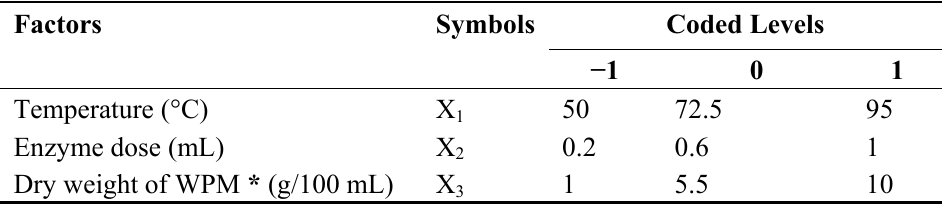
Table 1. Levels of factors chosen for the experimental design of liquefaction.